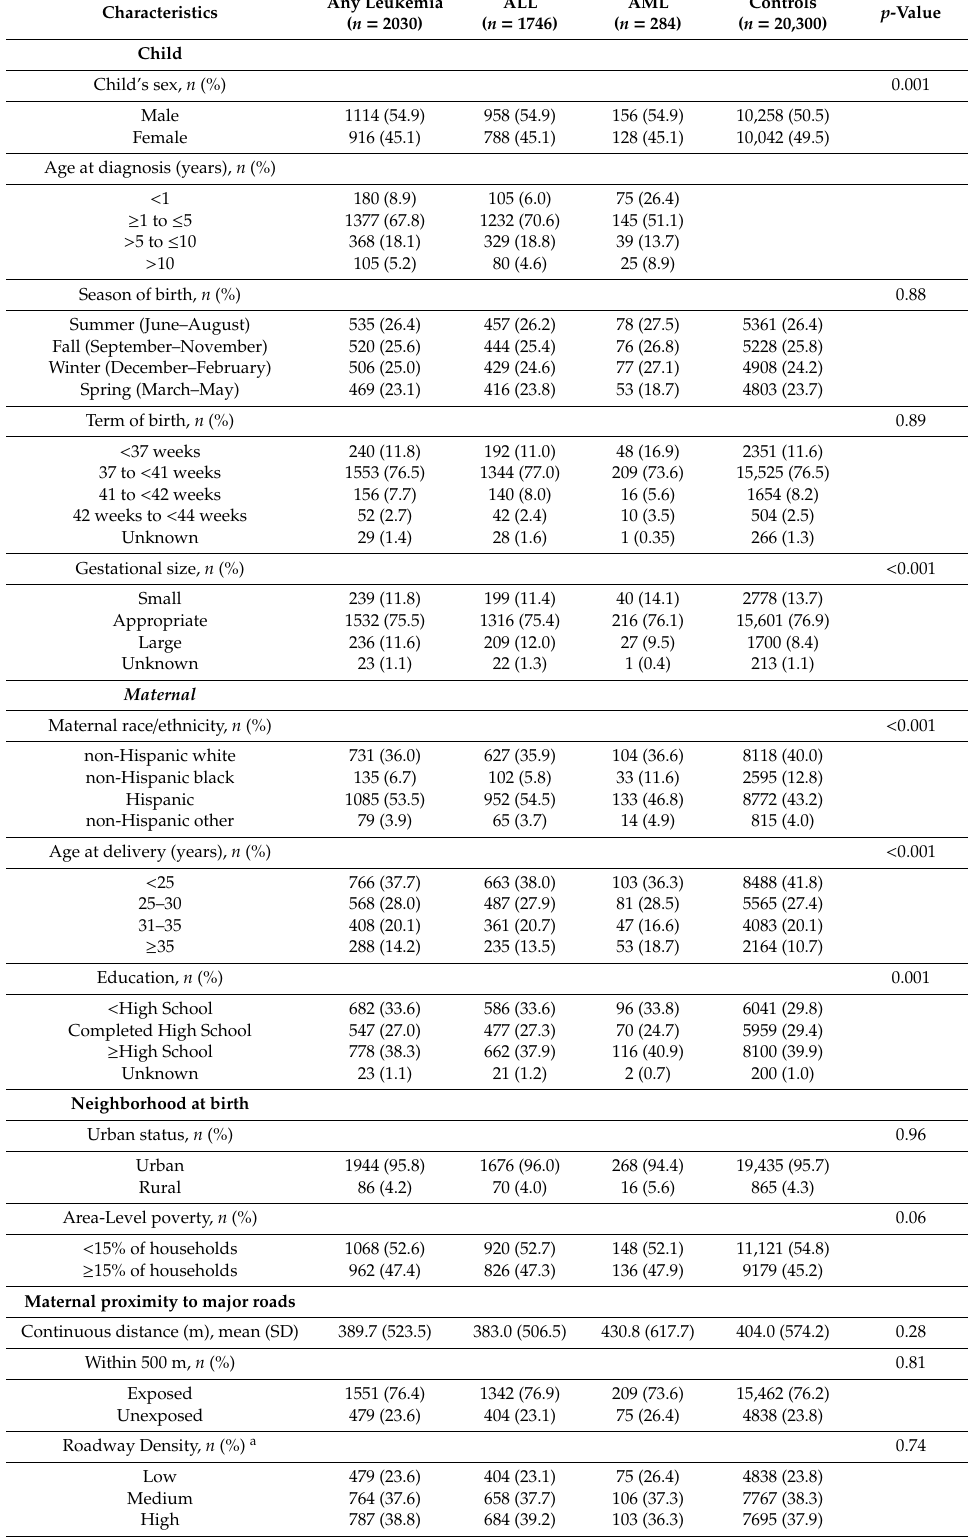
Table 1. Demographic characteristics of cases with acute leukemia and birth certificate controls in Texas,